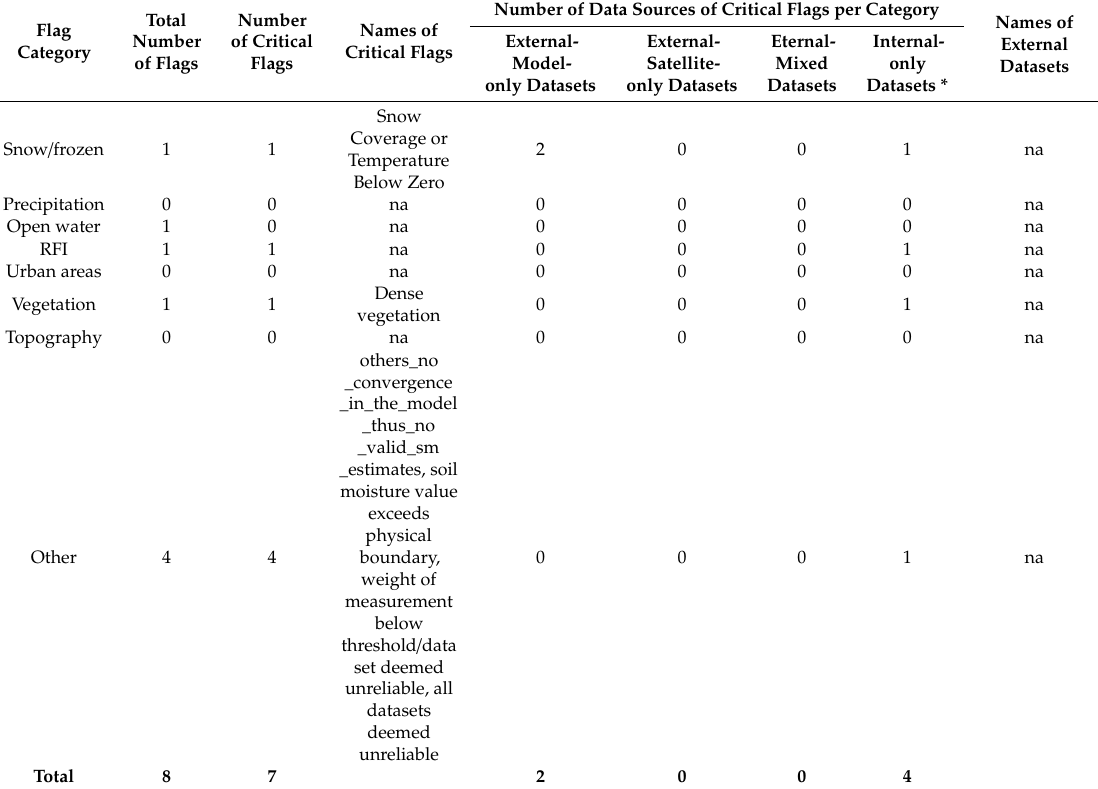
Table A3. Overview of the flagging system of the multi-sensor datasets of ESA CCI SM